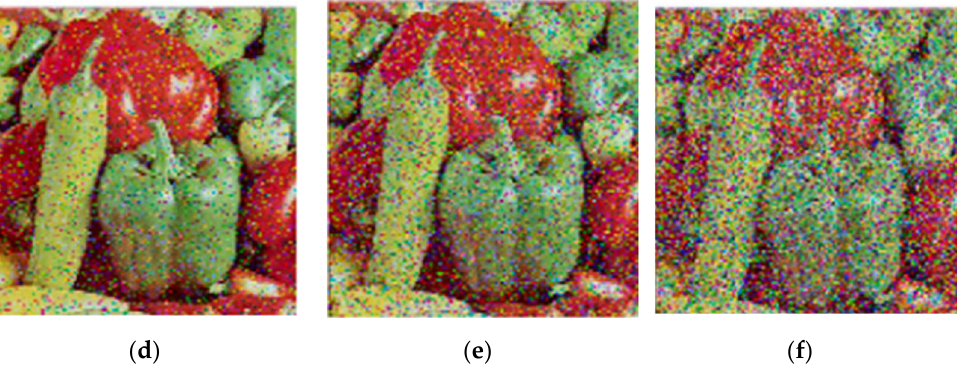
Figure 20. Simulation results of the occlusion attack: ( a ) 12.5% occlusion; ( b ) 25% occlusion; ( c ) 50% occlusion; ( d ) decryption image of ( a ); ( e ) decryption image of ( b ); ( f ) decryption image of ( c ).